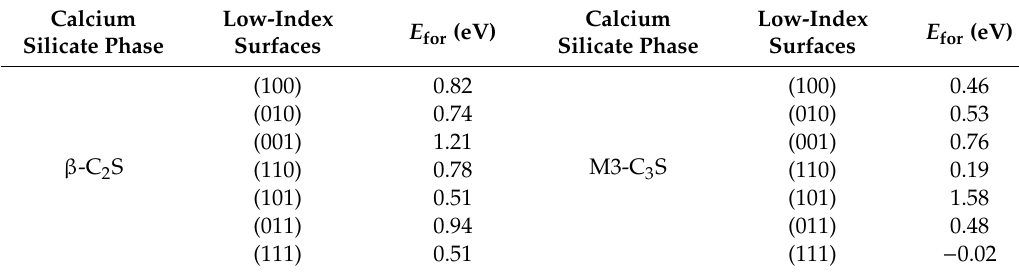
Table 1. Impurity formation energy ( E for ) of Mg substituting for Ca in low-index calcium silicates